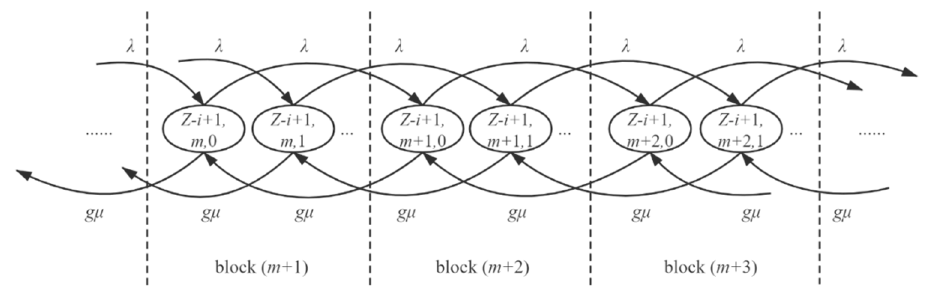
Figure 6. Transitions between blocks when x 1 = Z − i + 1, triggered by the arrival (rightward transitions) or departure (leftward transitions) of tasks.